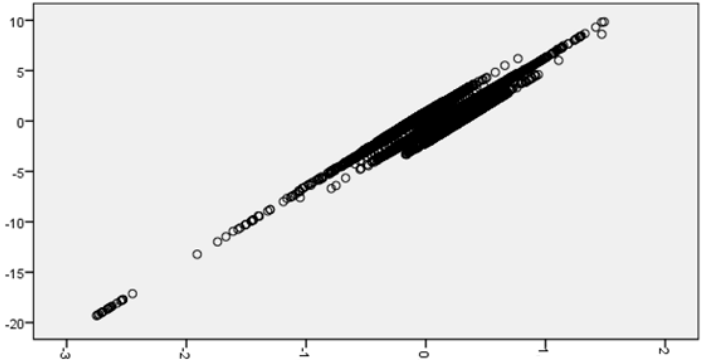
Figure 5. Scatter plot of the standardized residuals (vertical axis) according to the dependent variable (horizontal axis). Table 3. Characteristics and compositions of the clusters of